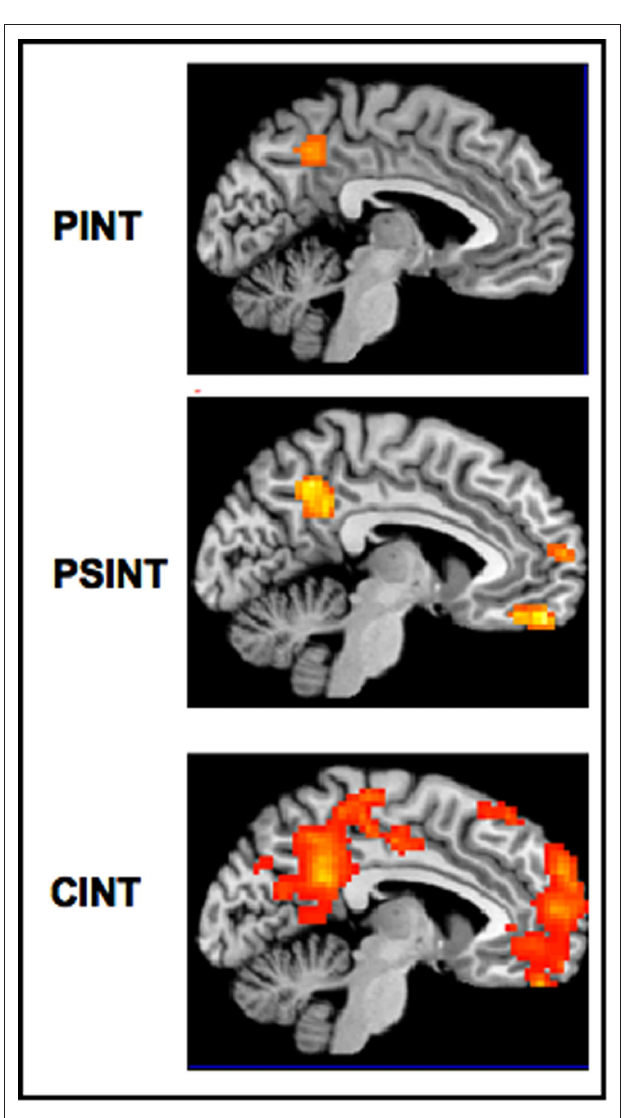
FIguRe 6 | Main effects for the three experimental conditions (PInt, PSInt, CInt) vs control condition (Ph-C). Second level, one sample t -test, p < 0.001 uncorrected. Ph-C, Physical causality; PInt, Private intention; PSInt, Prospective social intention; CInt, Communicative